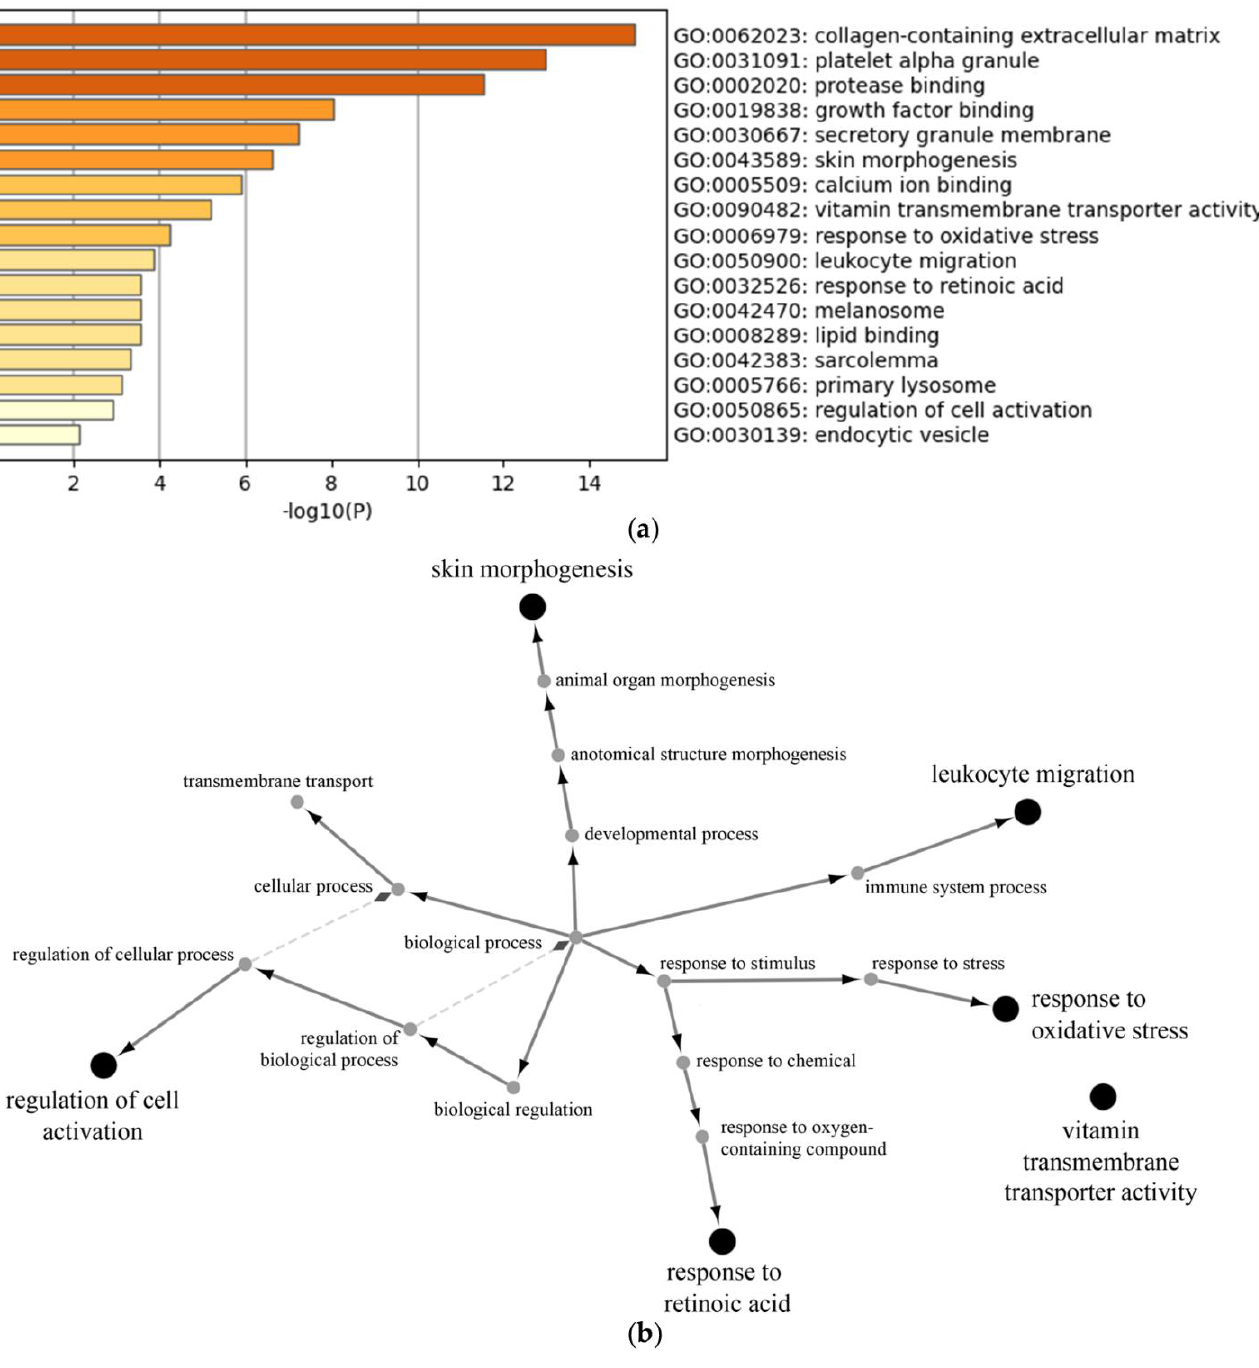
Figure 4. Gene ontology enrichment analysis of proteins downregulated by LPS in neutrophil-derived EVs. Enrichment clusters identified by Metascape ( a ) and functional analysis of enriched GO terms from the parent node to the root node, illustrated with ClueGo and Cluepedia in Cytoscape ( b ).